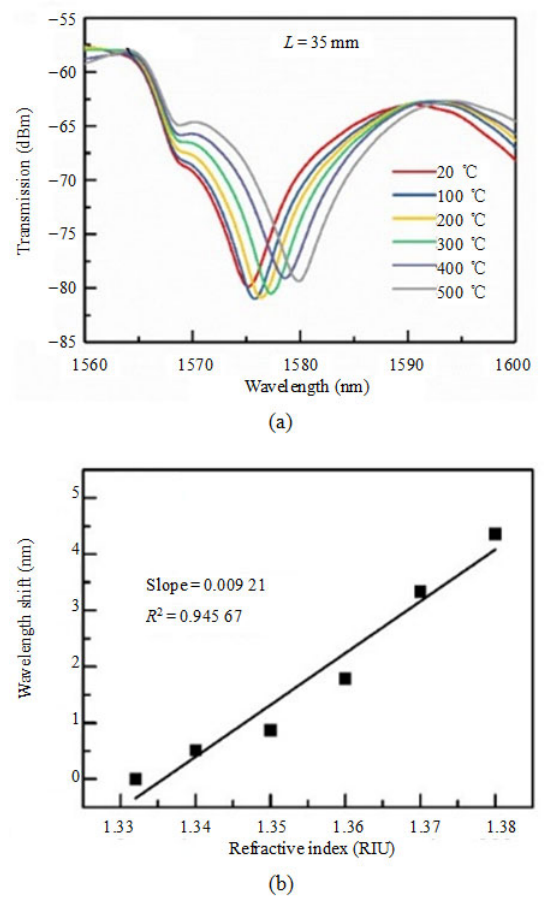
Fig. 8 Results of temperature response experiment: (a) transmission spectra of the PCF interferometer